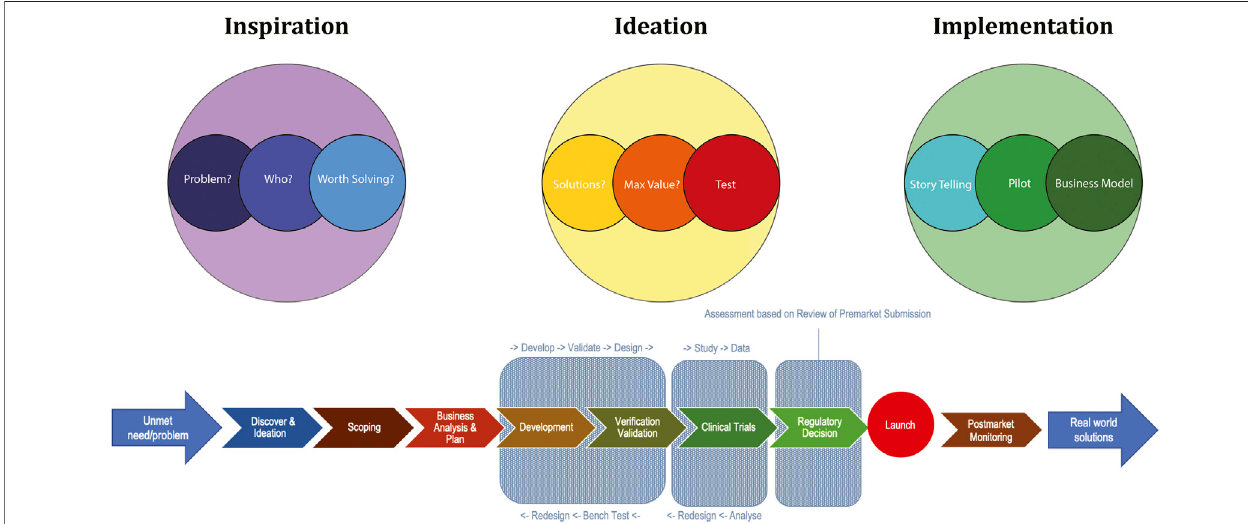
FIGURE 2 | Applying engineering design thinking and entrepreneurial thinking in the translational research process creates a systematic approach to fi nding a solution to a problem that is worth solving. In biomedical research this starts with identifying an unmet healthcare need or clinical problem. Scoping of the problem and undertaking a business analysis occurs at the beginning, ideas of how the problem may be solved are explored, re-iterated and then progress to implementation and a real world solution. (Flow chart component developed by Monash Institute of Medical Engineering, Monash University.)